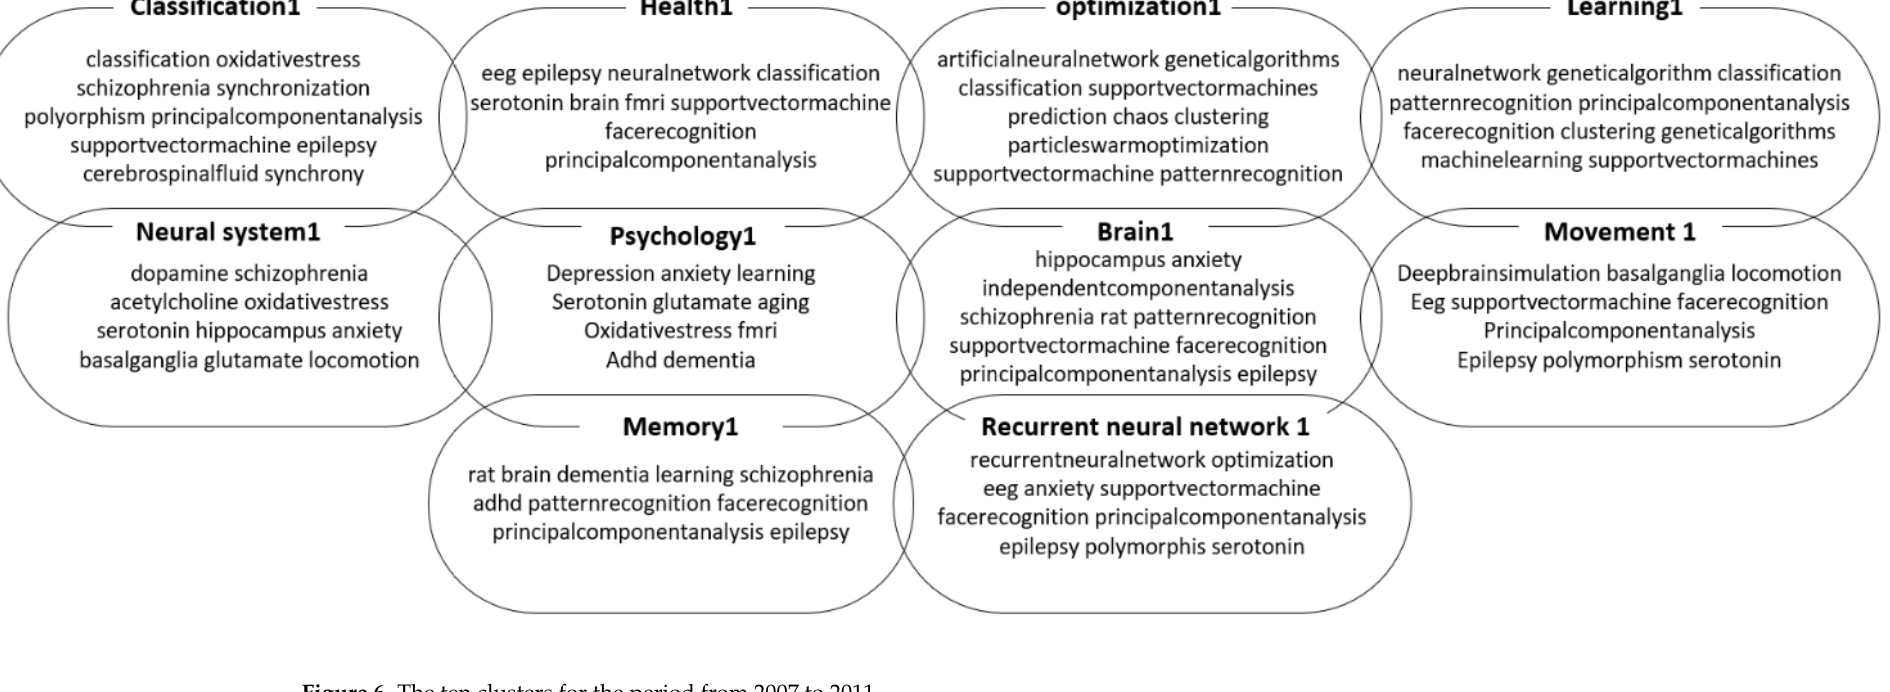
Figure 6. The ten clusters for the period from 2007 to